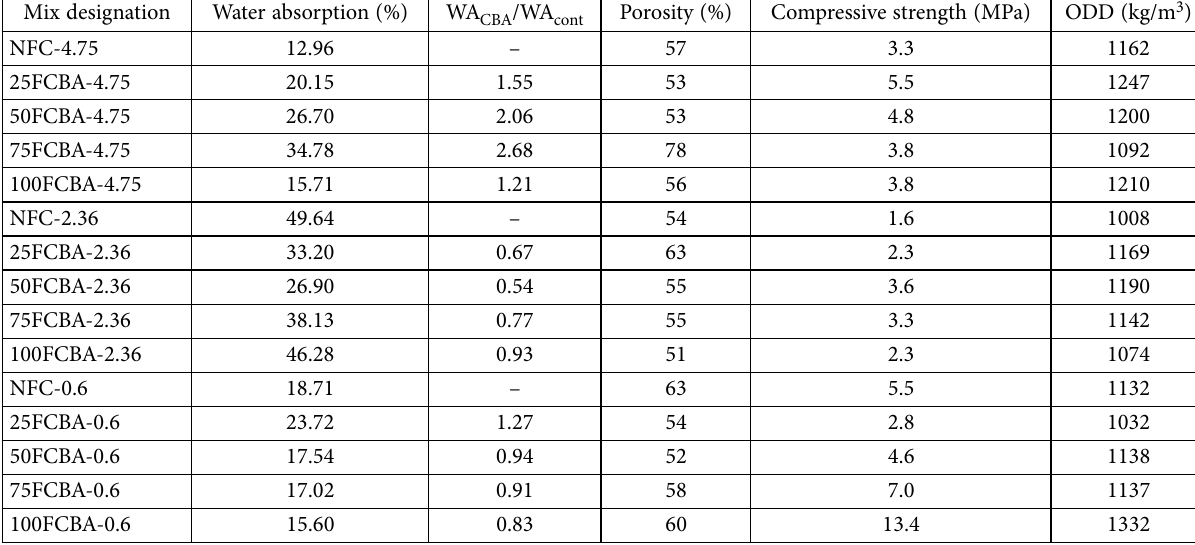
Table 8. Relationship between the water absorption, compressive strength and ODD of